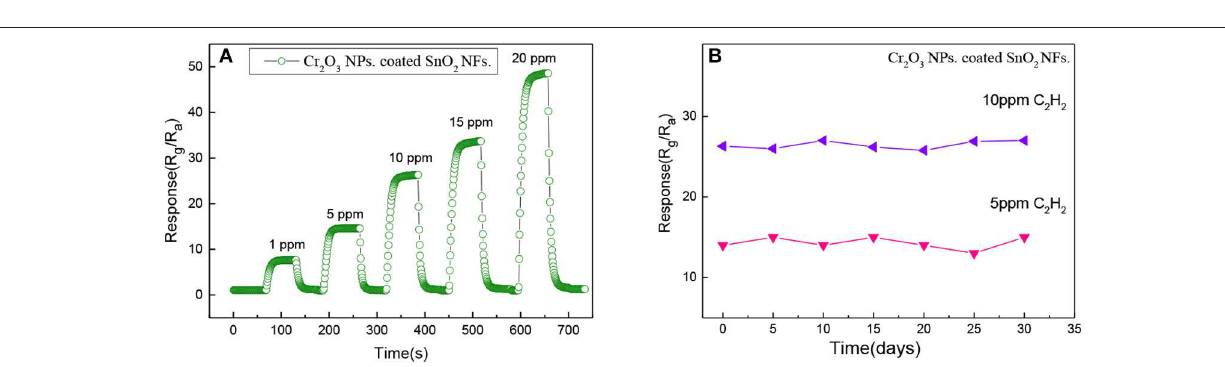
FIGURE 6 | (A) The gas response of the pure SnO 2 and Cr 2 O 3 NPs. coated SnO 2 NFs. toward 20 ppm of C 2 H 2 at different working temperatures (60–440 ◦ C); (B) the gas response of the Cr 2 O 3 NPs. coated SnO 2 NFs. to different concentrations (0–1,000 ppm) C 2 H 2 at 220 ◦ C and (C) the gas response of the Cr 2 O 3 NPs. coated SnO 2 NFs. in the range from 0 to 80 ppm C 2 H 2 at 220 ◦ C.